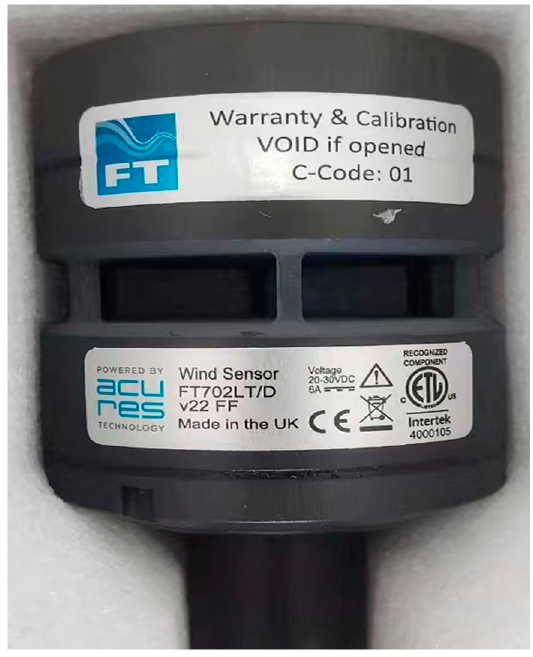
Figure 4. FT702LT-V22-FF anemometer.